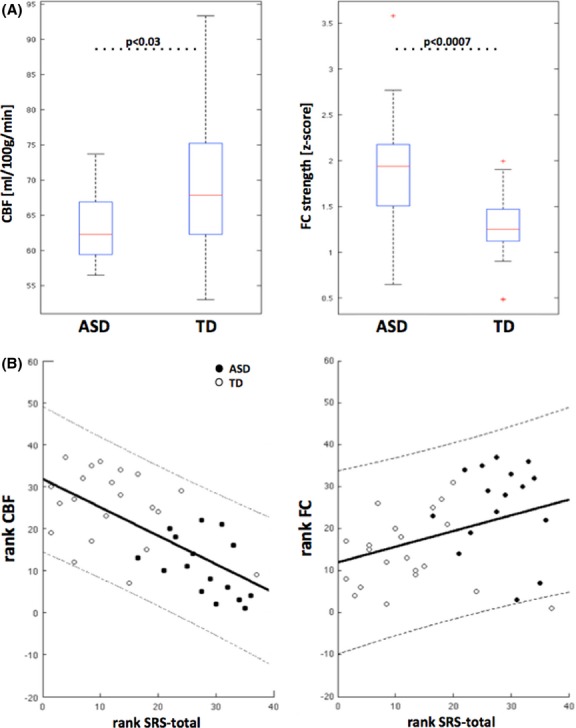
(A) Region of interest (ROI) analysis within the dorsal anterior cingulate cortex (dACC) and group differences between autism spectrum disorders (ASD) and typically developing (TD) displayed as boxplot. ASD exhibits increased functional connectivity (FC) along with reduced cerebral blood flow (CBF) in this specific area. (B) Region of interest (ROI) analysis within the dACC and association to disease severity: Spearman’s rank correlations between Social Responsiveness Scale (SRS)-total scores and functional connectivity (FC) and CBF, respectively. CBF was corrected for global GM-CBF and age (empty circles: TD/filled circles: ASD/line and dashed lines: linear fit and 95% confidence boundaries). There is a significant relation between SRS scores and FC as well as CBF, however, with opposite sign.